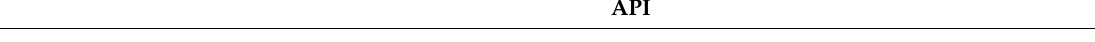
Table 2. Tensorflow.js API compatibility table.